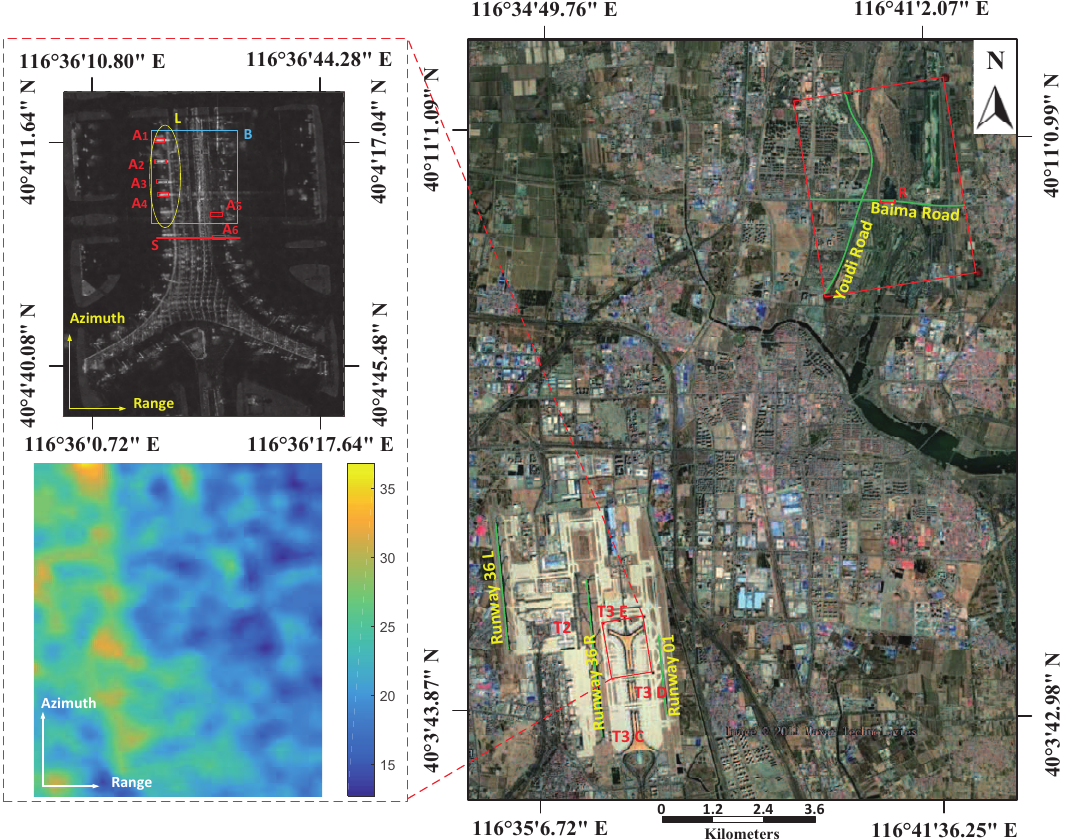
Figure 3. Shunyi District from Google Earth. The study areas are the T3 E building and the Chaobai River marked with red rectangles. T he top and bottom sub-images at the left side are SAR intensity map and referred DEM map of T3 E, respectively. Several lounge bridges marked with A 1 – A 6 and most likely overlaid area L and part of the T3 E building marked by B are selected for quantitative comparisons of urban areas. The Chaobai River bridge marked with region R is selected for quantitative comparisons of non-urban